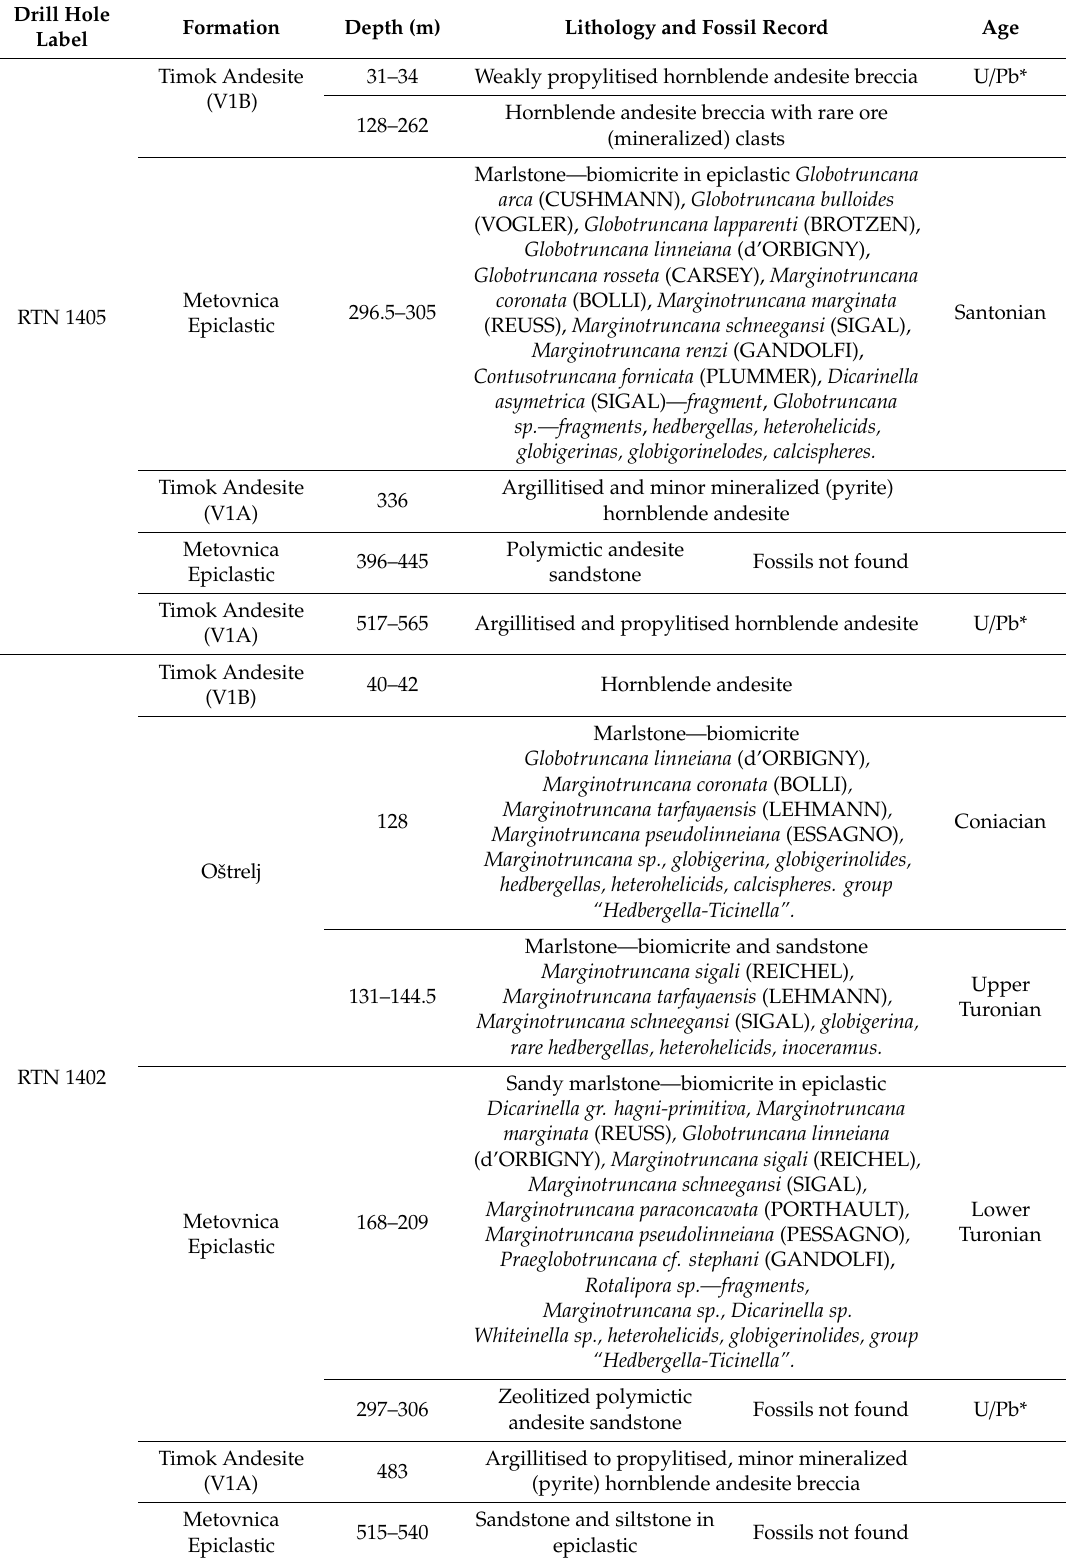
Table 1. Summary on lithological and paleontological characteristics of the studied drill holes. * see ages in Table